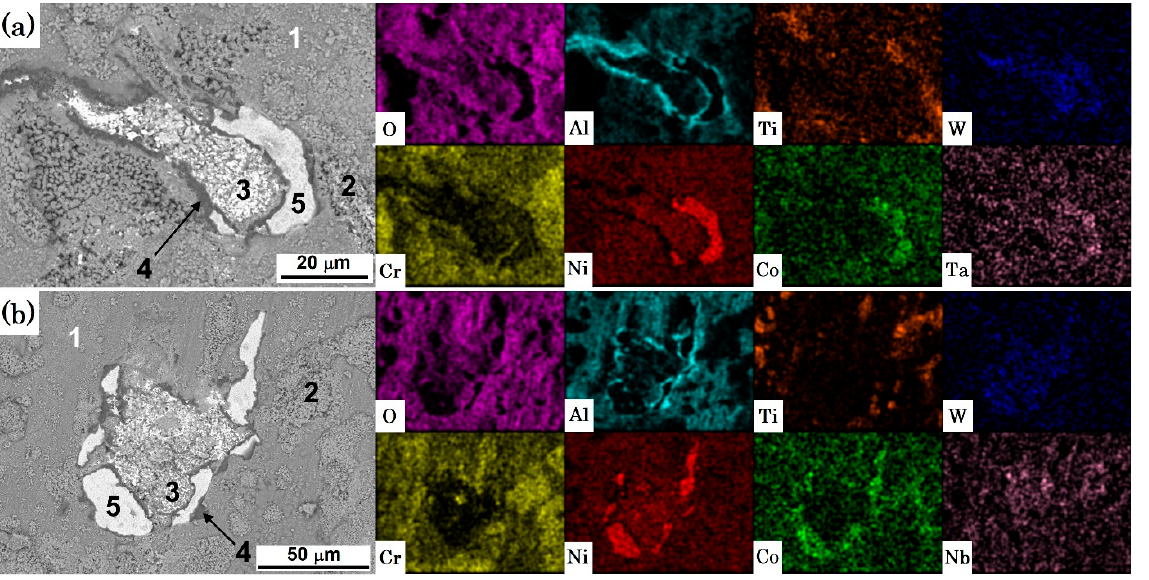
Figure 4. SEM and EDS mapping of elements for 180 cycles at 1000 °C on the top of the specimens. ( a ) MAR-M246(Ta), ( b ) MAR-M246(Nb).